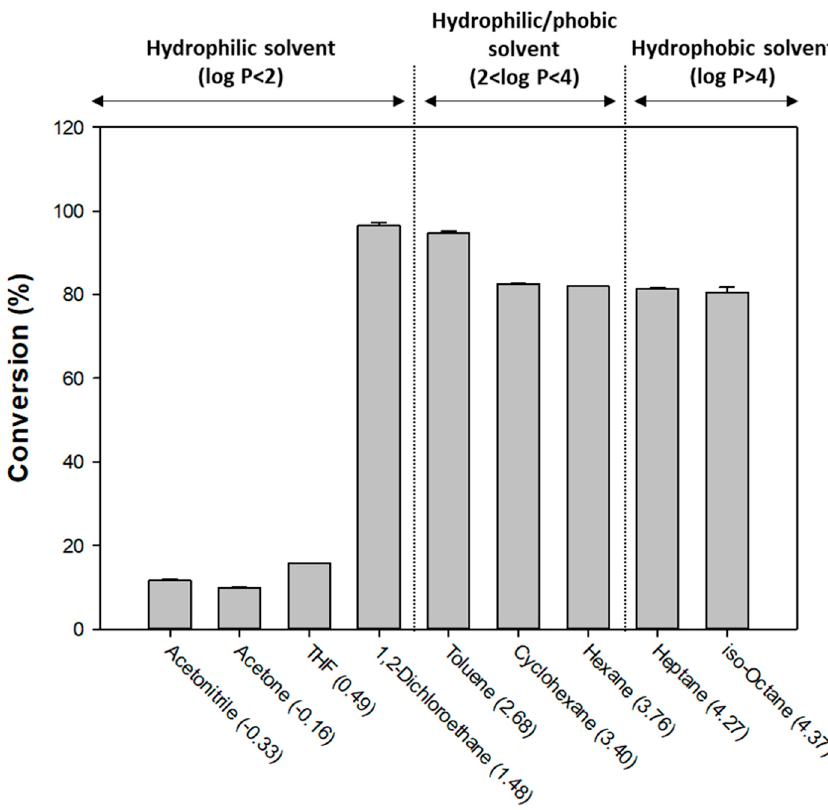
Figure 6. Conversion of octyl formate using various solvents.